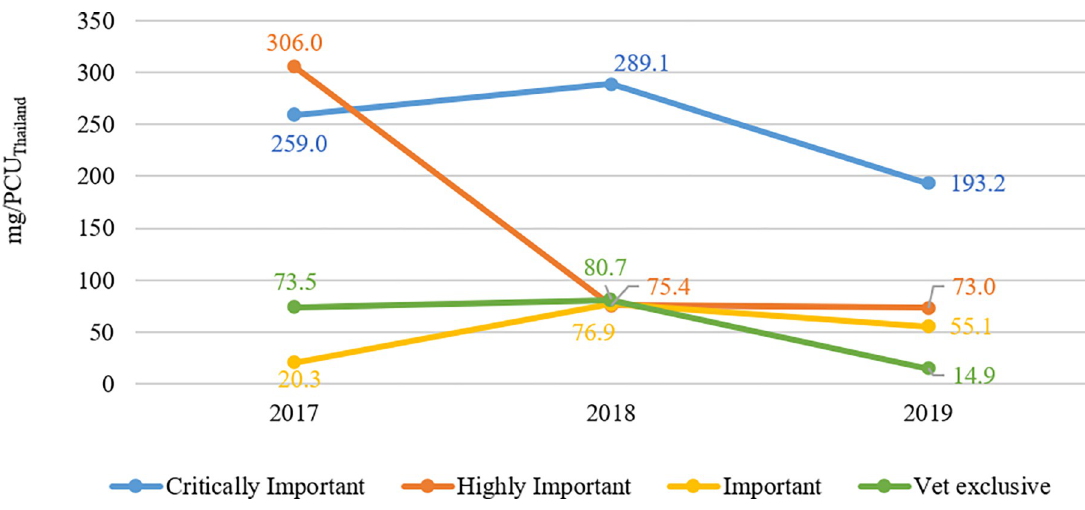
Fig 3. Trends of antimicrobial consumption in food-producing animals by WHO CIA list (2017–2019) (mg/PCU Thailand ).